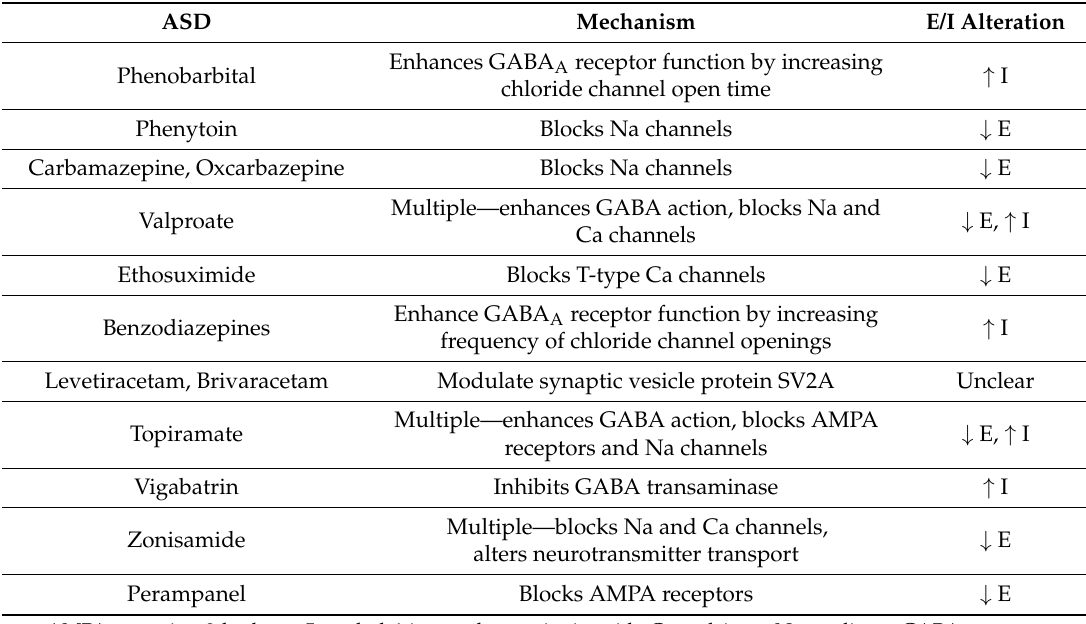
Table 2. Mechanisms of selected antiseizure drugs (ASDs). ASD Mechanism E/I Alteration Enhances GABA A receptor function by increasing ↑ I Phenobarbital chloride channel open time Phenytoin Blocks Na channels ↓ E Carbamazepine, Oxcarbazepine Blocks Na channels ↓ E Multiple—enhances GABA action, blocks Na and ↓ E, ↑ I Valproate Ca channels Ethosuximide Blocks T-type Ca channels ↓ E Enhance GABA A receptor function by increasing Benzodiazepines frequency of chloride channel